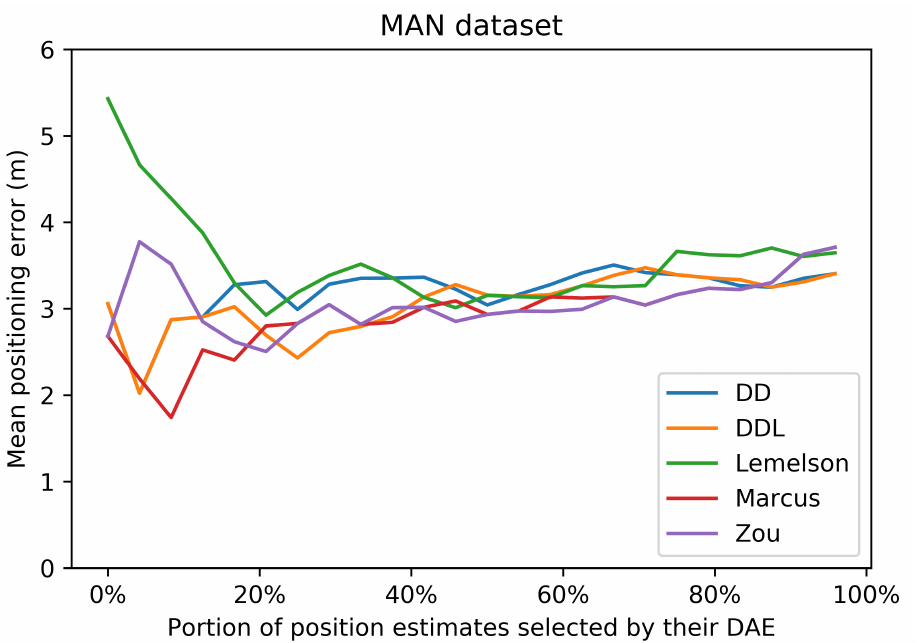
Figure 25. In this plot, the horizontal axis represents the percentage of location estimates selected based on their ranking according to the DAE values. The ranking of each DAE method is depicted with a different color. The vertical axis reports the respective mean positioning error for each selected portion of the original dataset. The values correspond to the validation set of the MAN